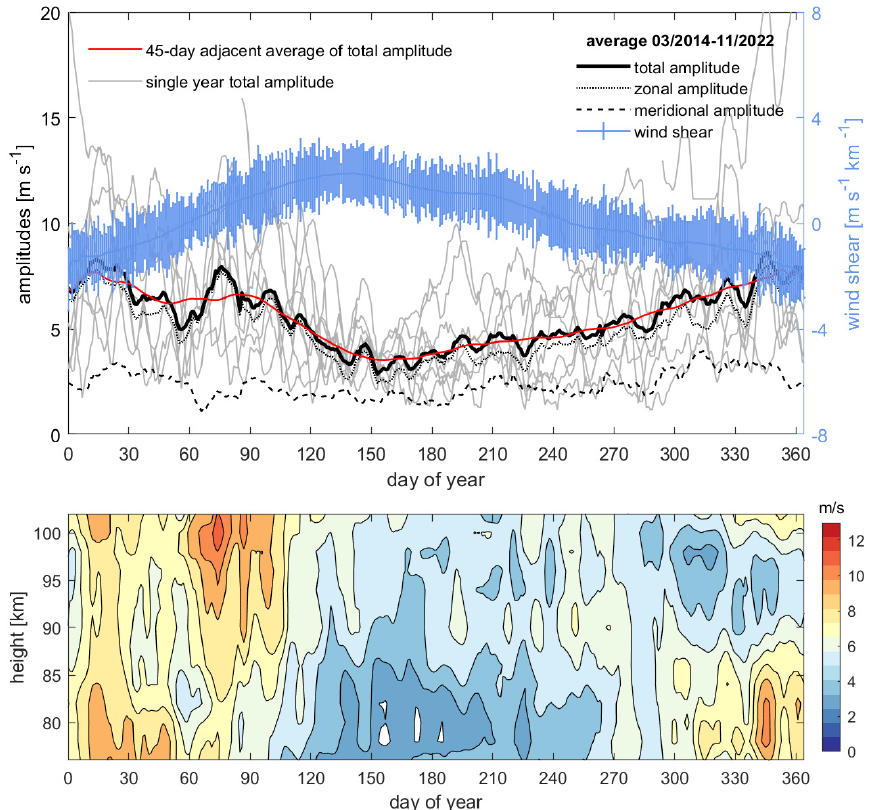
Figure 9. Top panel: Light gray lines indicate the annual Q16DW amplitudes at 84 km for each year between April 2014 and December 2022. The thick black line indicates the mean of the total Q16DW amplitudes from 2014 to 2022, whereas the meridional and zonal components are denoted by the dashed and dotted lines, respectively. The smooth red line represents the 45-day adjacent mean for the multiyear averaged amplitude. The blue curve and error bars show the vertical zonal wind shear and its standard deviation, respectively. Bottom panel: the 9-yr mean total amplitudes of Q16DW as a function of height in an annual cycle (shading and contour).